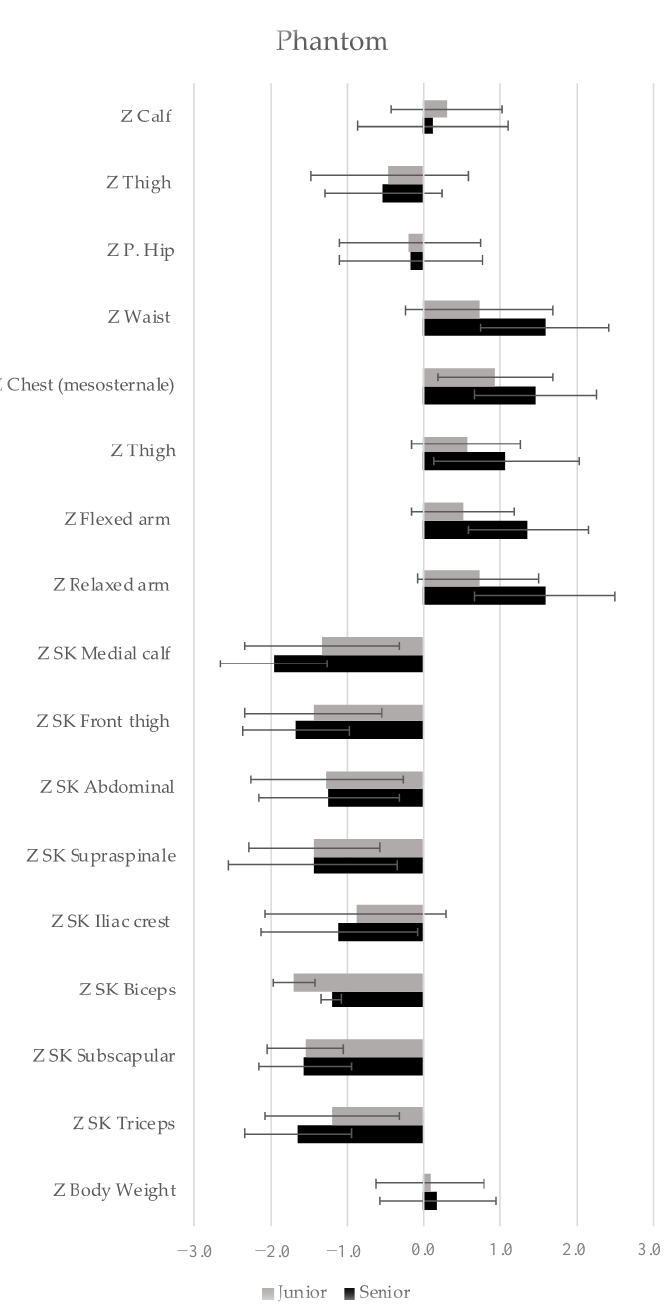
Figure 3. Representation of the proportionality with respect to the phantom. SK = Skinfolds. Data are presented as mean and standard deviation.